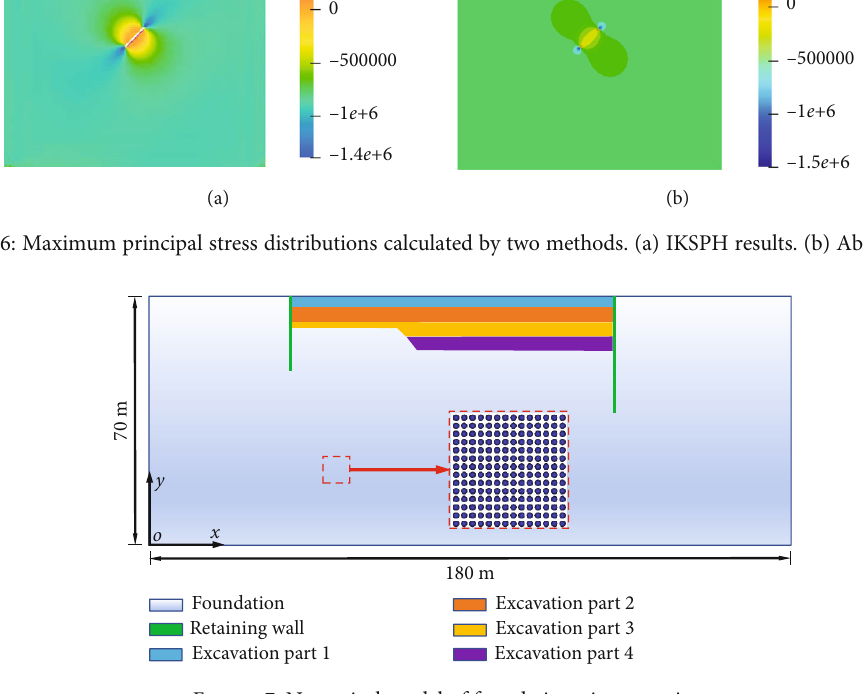
Figure 7: Numerical model of foundation pit